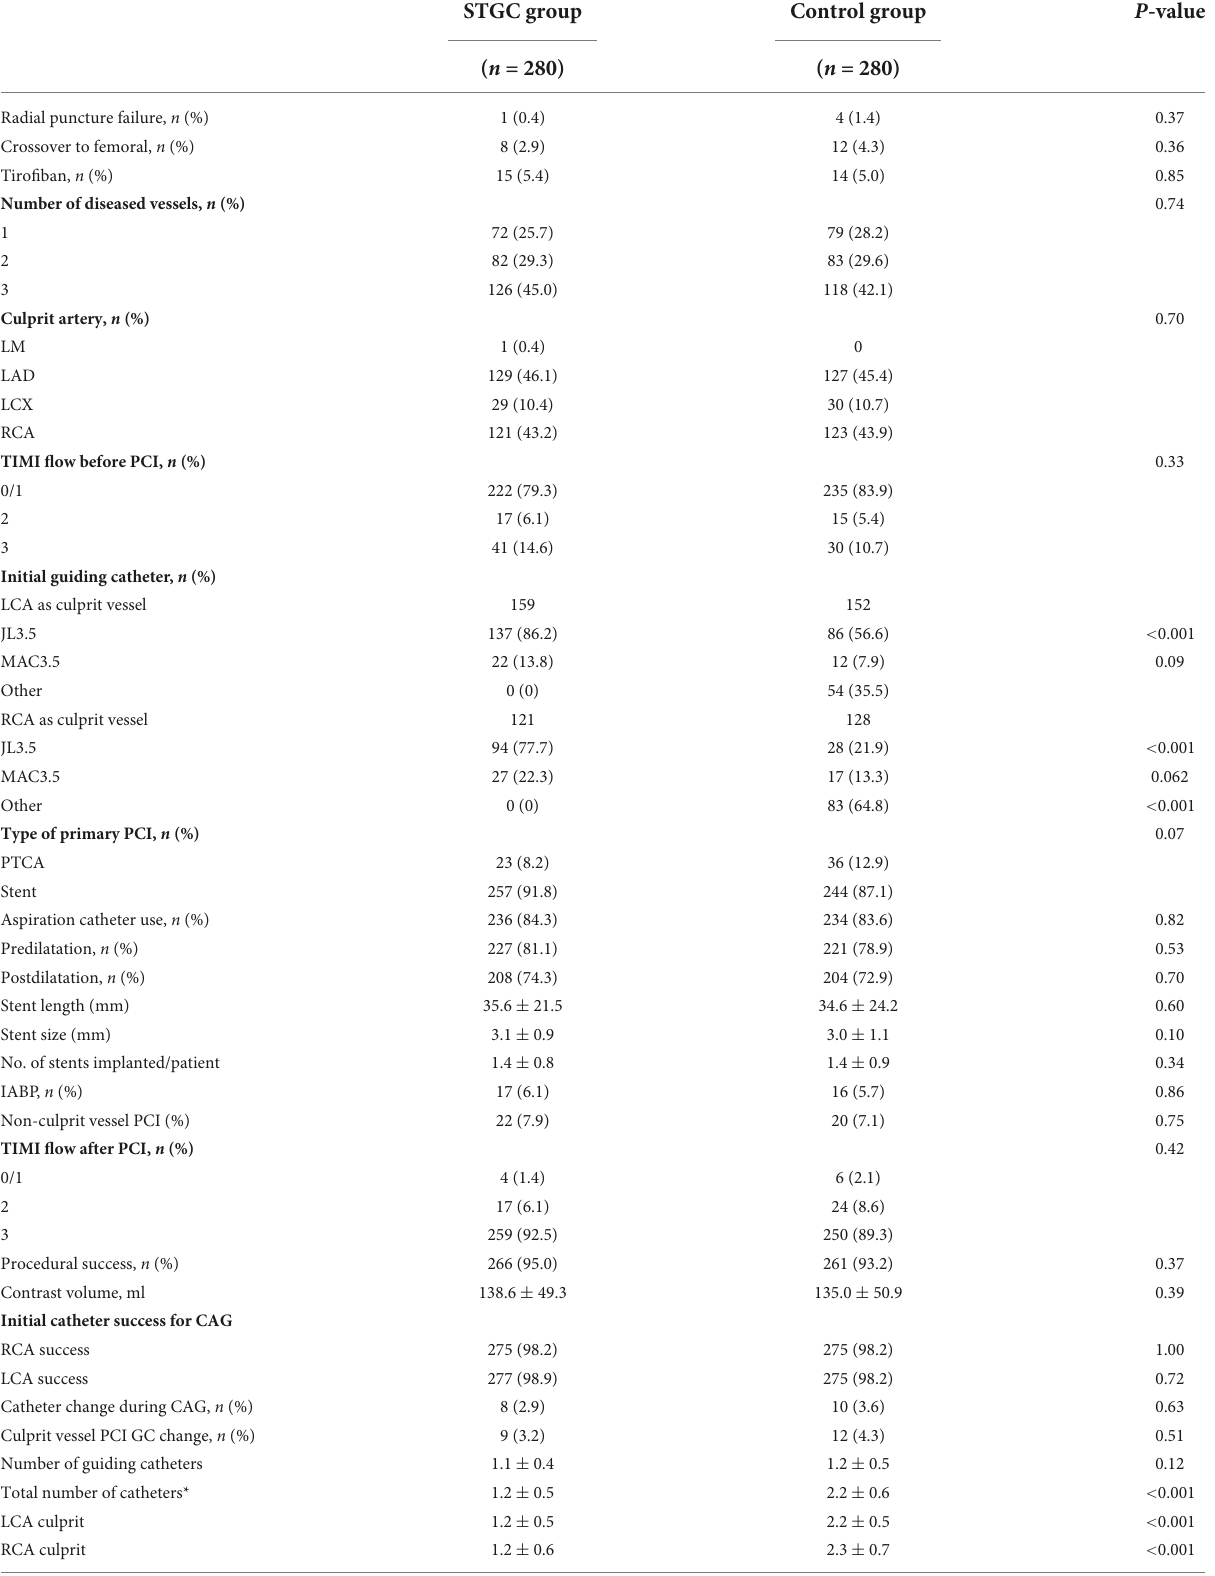
TABLE 2 Procedural